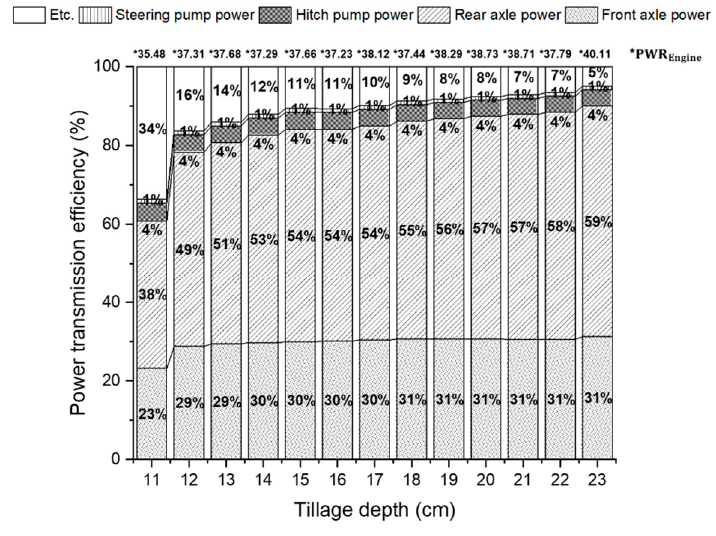
Figure 14. Power transmission efficiency with respect to engine power.